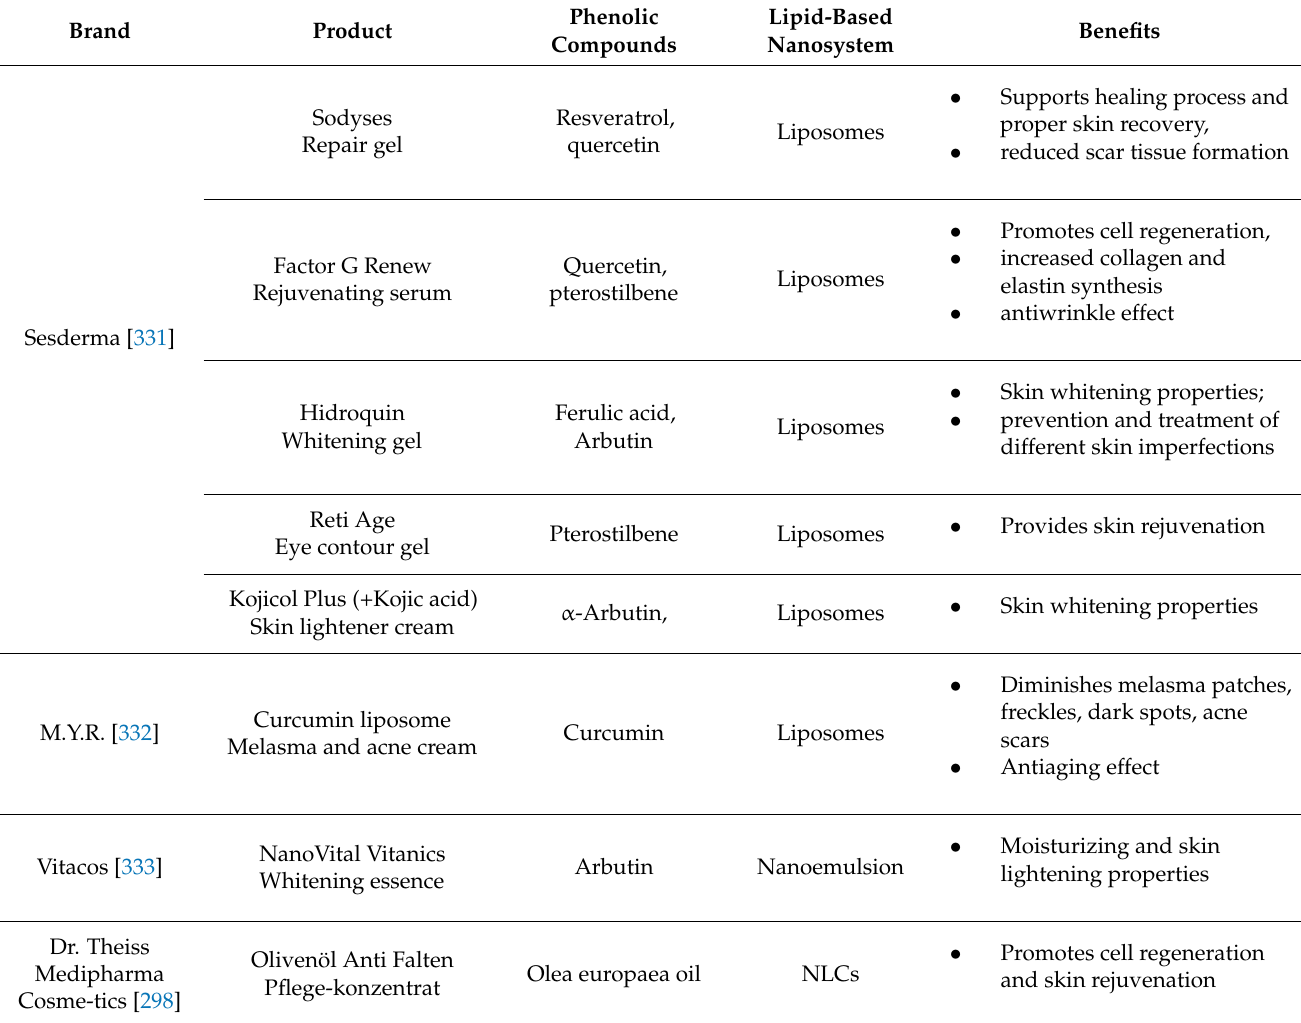
Table 3. Cosmetic products containing phenolic phytochemicals formulated via nanotechnological